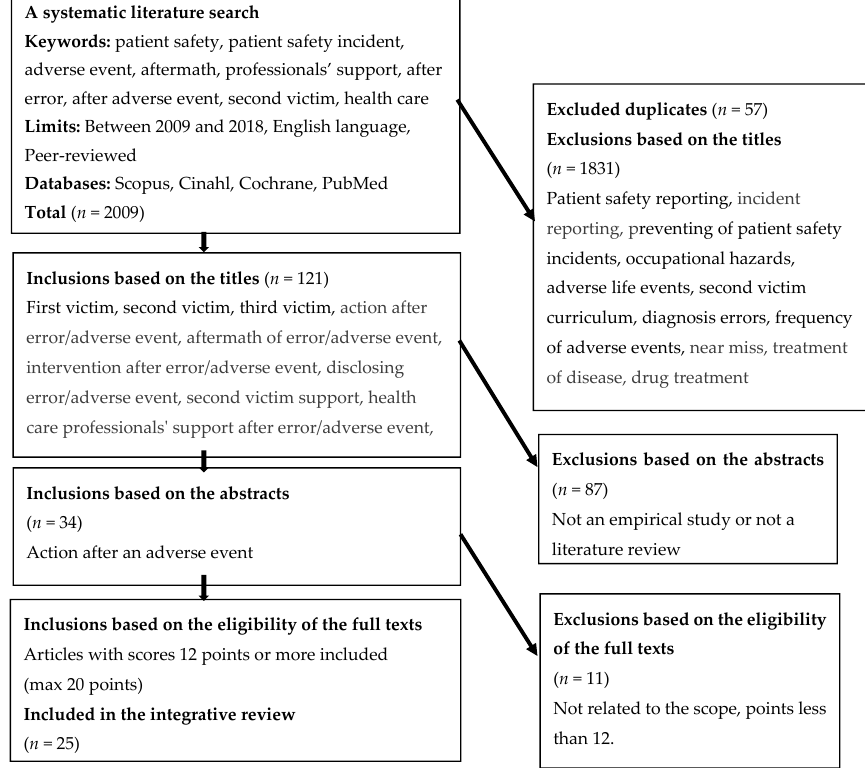
Figure 1. Systematic literature search process regarding action after adverse